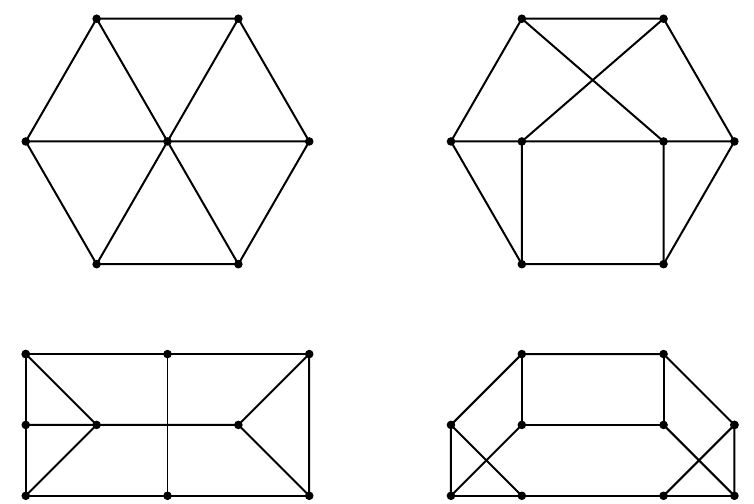
Figure 6 . Examples of vacuum diagrams at six loops with 12 , 13 , 14 and 15 denominators (reading from left to right and top to bottom). The larger the number of propagators, the larger the number of numerators we must include to ensure vanishing ω 0